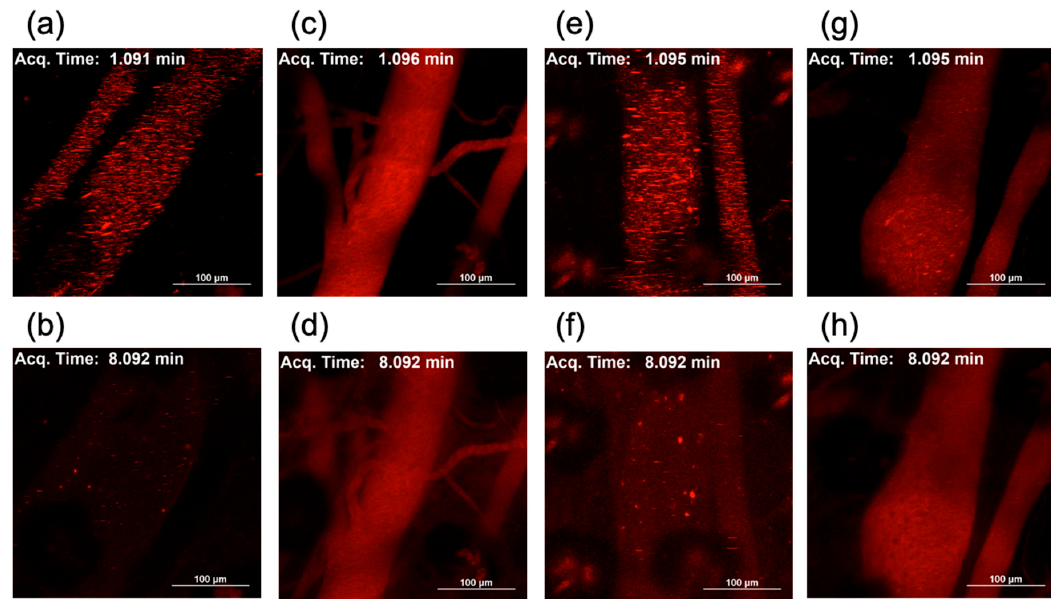
Figure 8. Intravital real-time confocal observation of Lipofectamine LTX-based LNPs in the blood. Using GLuc mRNA labeled with Cy5, two LNP formulations were prepared by mixing the mRNA with minimal or maximal volume of lipofectamine LTX solution that the manufacture suggests to use (( a – d ) Lipo-Min and ( e – h ) Lipo-Max). Then, the LNPs was intravenously injected to the mice for observation of the blood vessel in the earlobes using intravital confocal microscopy. ( a , c , e , g ) Images 1 min after the injection. ( b , d , f , h ) Images 8 min after the injection. ( a , b ) Lipo-Min loaded with non-PEGylated mRNA. ( c , d ) Lipo-Min loaded with 20 PEG-OligoRNAs/mRNA. ( e , f ) Lipo-Max loaded with non-PEGylated mRNA. ( g , h ) Lipo-Max loaded with 20 PEG-OligoRNAs/mRNA.